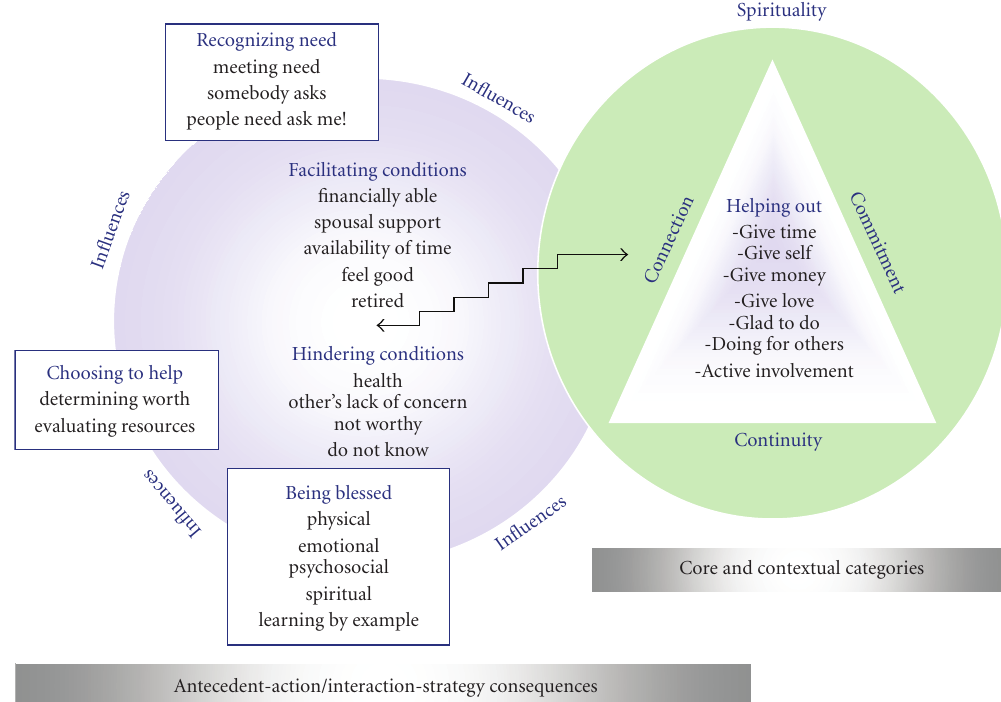
Figure 1: Theory of “becoming” an older